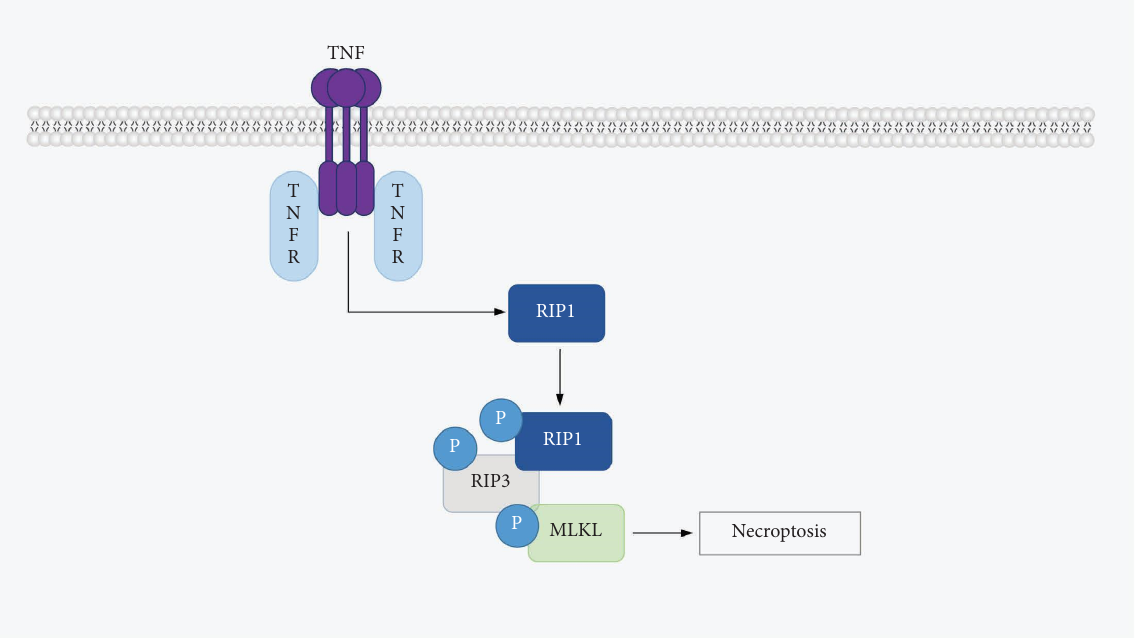
Figure 6: Molecular mechanism of necroptosis pathway.